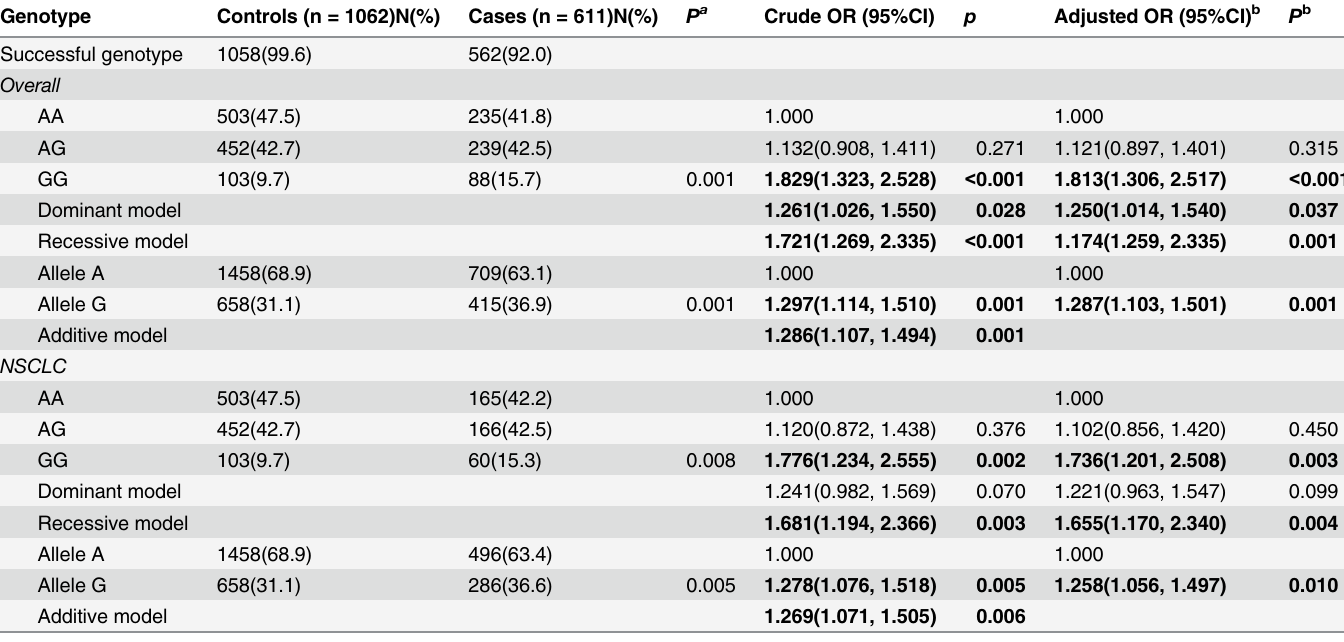
Table 2. Association between rs931794 and lung cancer risk in a Chinese